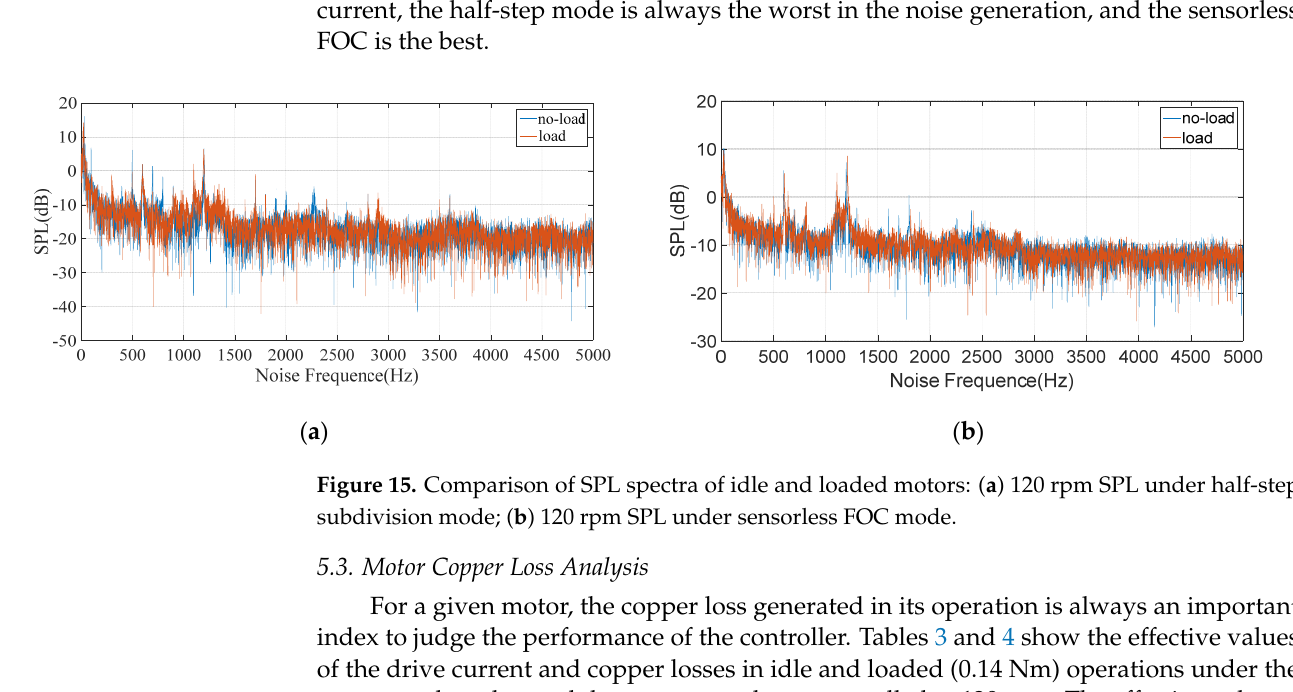
Figure 14. Testing result: the SPL spectrum of the motor at 120 rpm loaded operation.